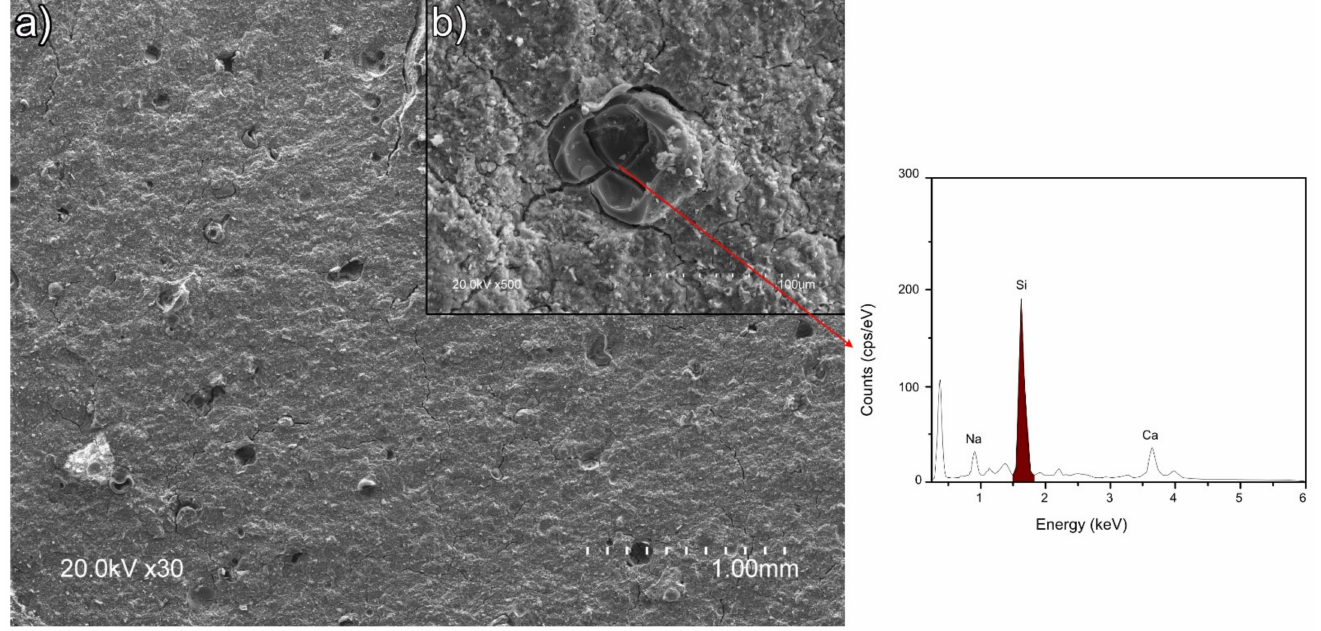
Figure 8. SEM micrograph of sample 5NSi showing: ( a ) porous zones and ( b ) enlargement of insoluble